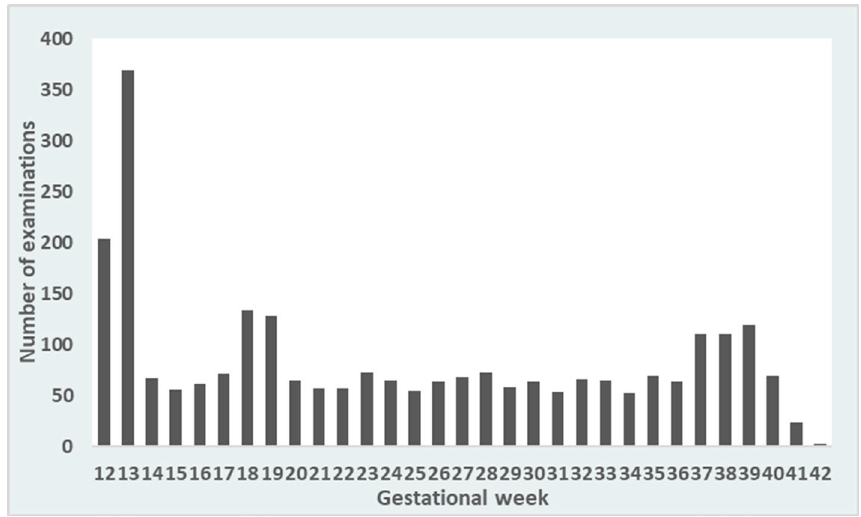
Figure 1. Distribution of ultrasound examinations by gestational age.